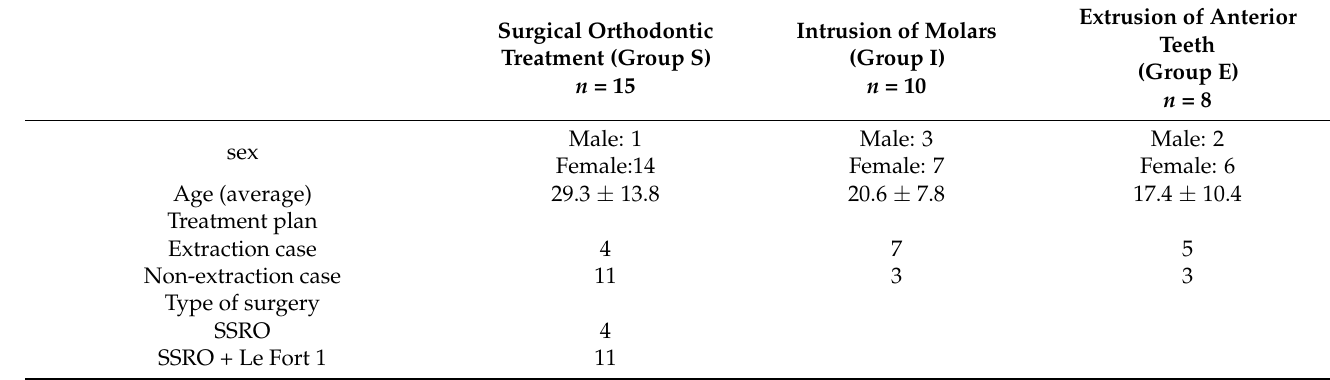
Table 1. Patients’